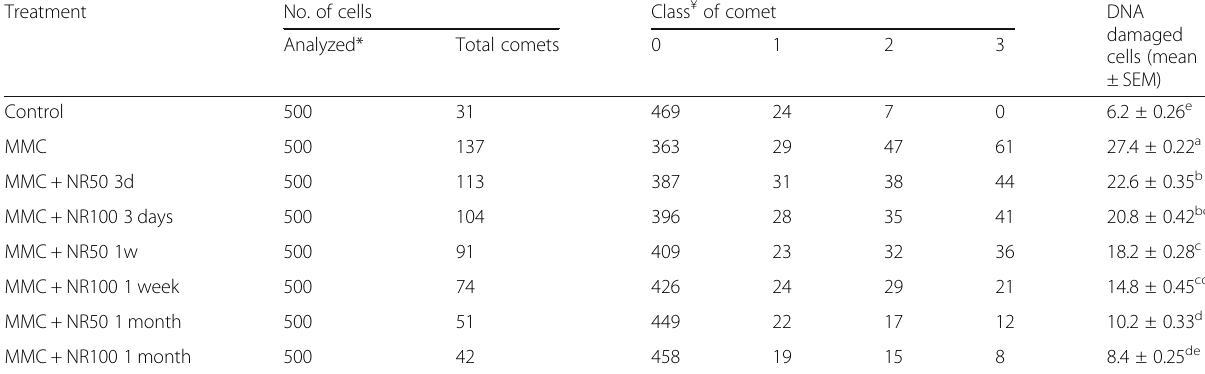
Table 4 Rate of DNA damage in liver tissues of MMC-treated mice supplemented with different doses (50 and 100 mg/kg body wt) of Nitraria retusa leaf extracts at different time intervals (3 days, 1 week, and 1 month) using comet assay Treatment No. of